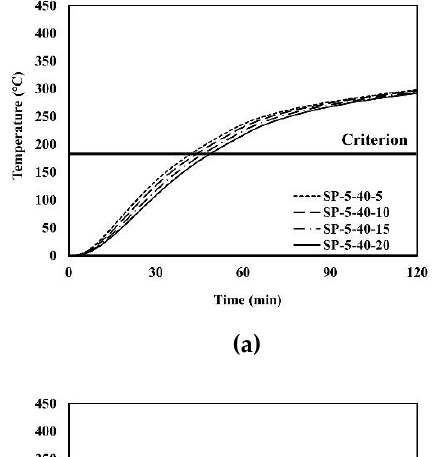
Figure 16. Time history of average temperatures with dp = 40 mm: ( a ) SP-5-40- x; ( b ) SP-10-40-x; ( c ) SP-15-40-x; ( d ) SP-20- 40-x.